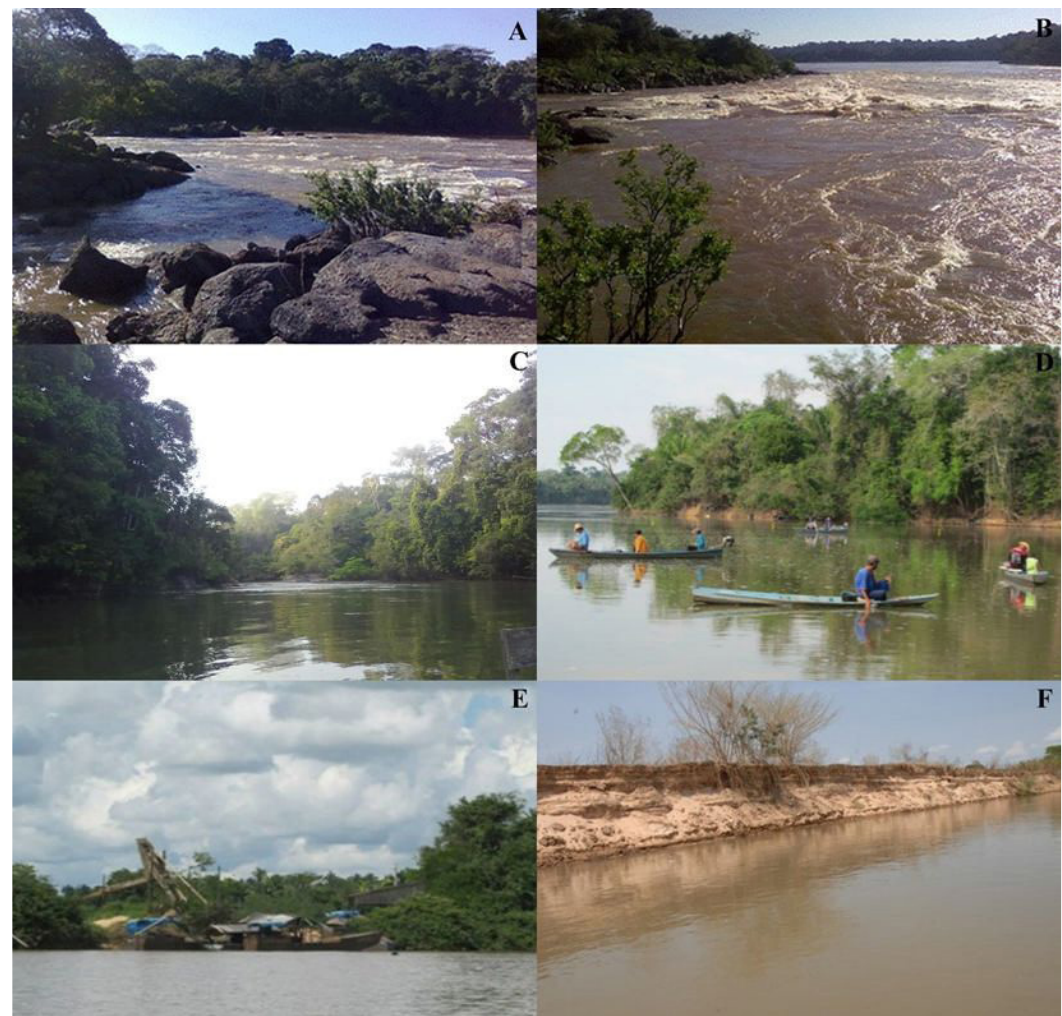
Figure 2. Sampling sites in the Machado River Basin, Rondônia, Brazil: (A) Carmita; (B) Farofa; (C) Suretama (preserved area); (D) São Sebastião, fishing activities; (E) sand dredging activity; and (F) Poção, pasture, few woody angiosperms and stretches of bare bushes, degraded local banks and (impacted